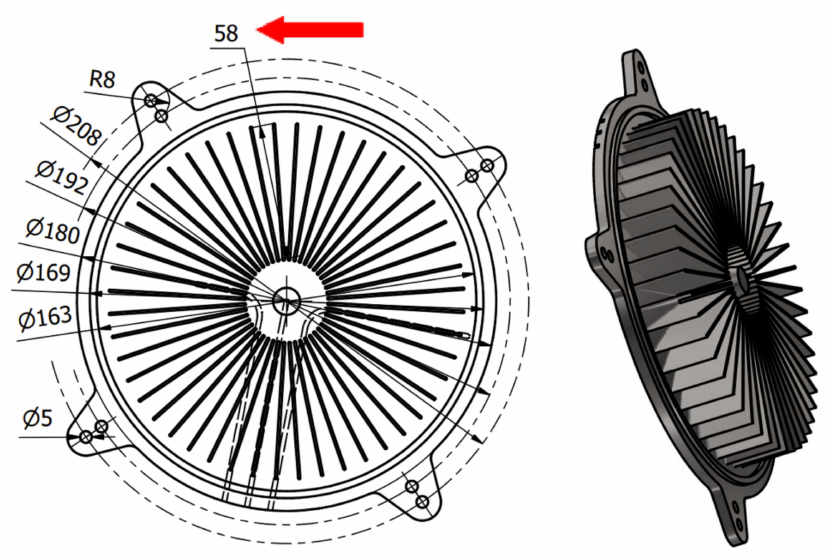
Figure 3. Illustrative drawing of radiator variant No.